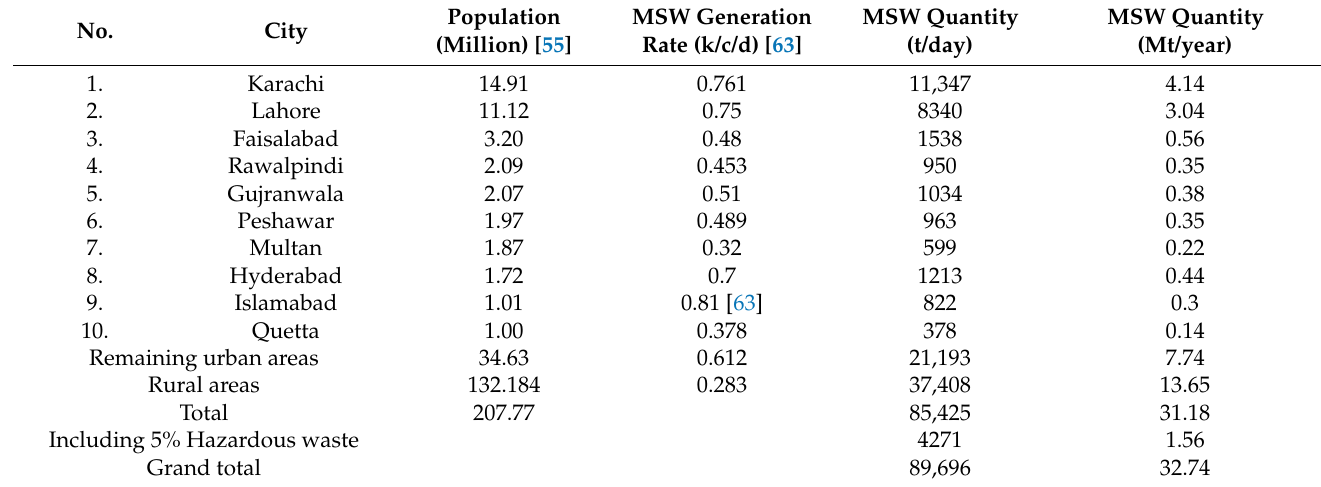
Table 2. Quantity of MSW generation in top ten populated cities of